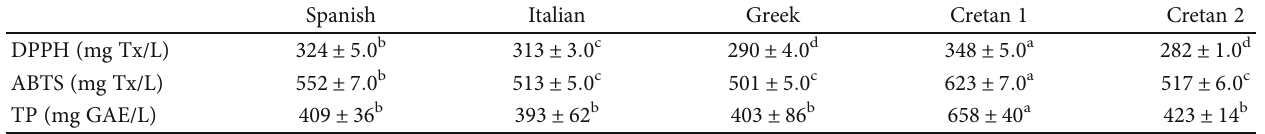
Table 1: Antioxidant capacity and total polyphenols of extra virgin olive oils. Spanish